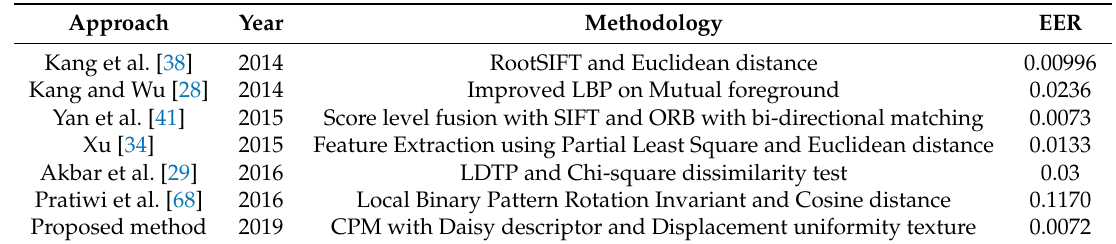
Table 9. Comparison of our method with other methods of the